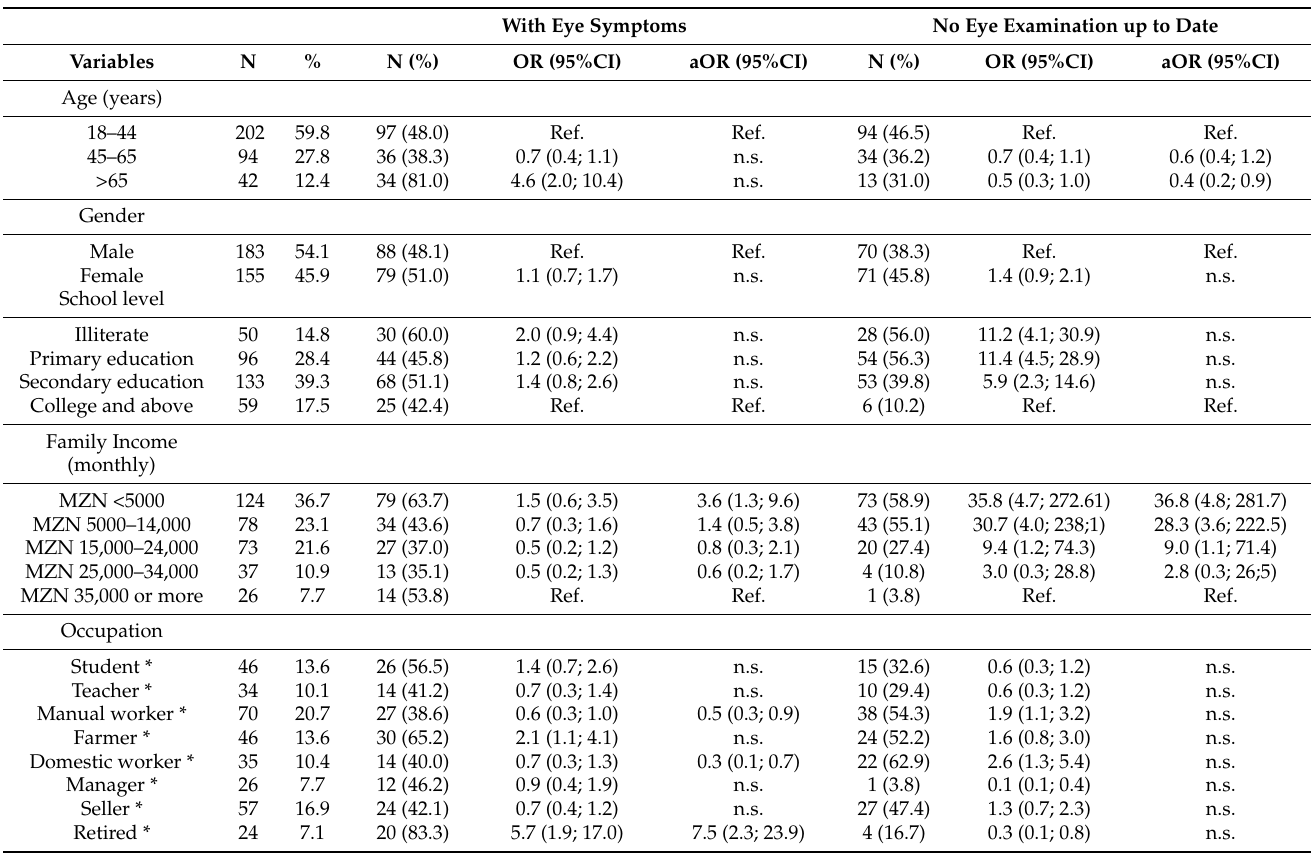
Table 1. Description of socio-demographic characteristics and association with the presence of symptoms and the lack of eye examination being up to date. With Eye